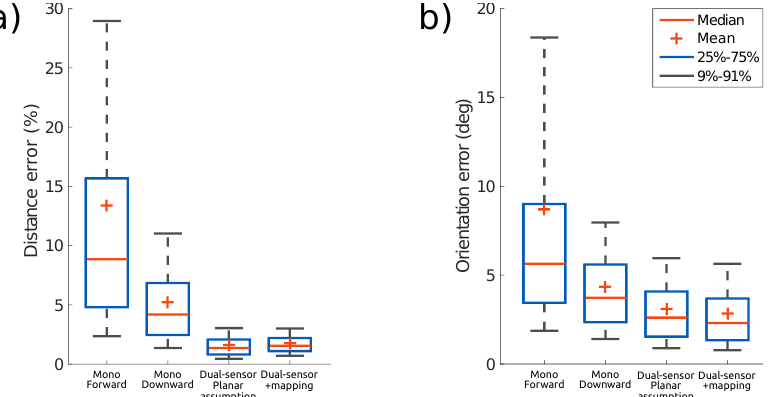
Figure 16. Statistical comparison of the results obtained with the dual-sensor experiment (Figure 15), with only one sensor pointing forward, only one sensor pointing downward, two sensors without any mapping updates, and two sensors with mapping updates, respectively. ( a ) Translation errors as a percentage of scene depth. ( b ) Rotational error in terms of the geodesic distance between the estimated and the ground truth